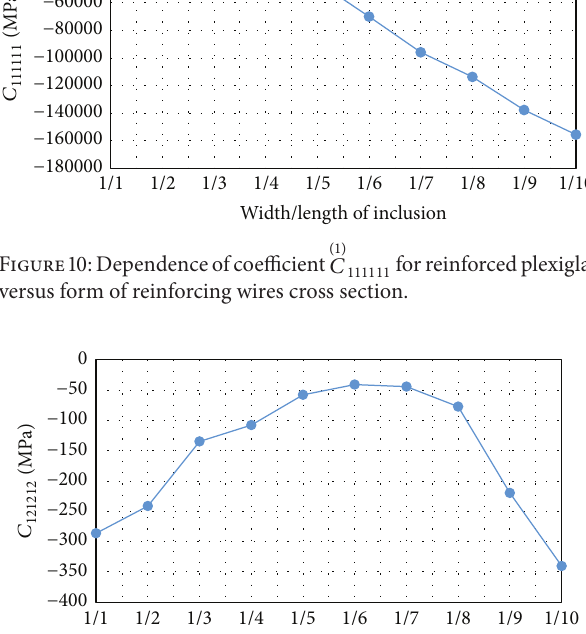
(1) 𝐶 121212 for reinforced plexiglas